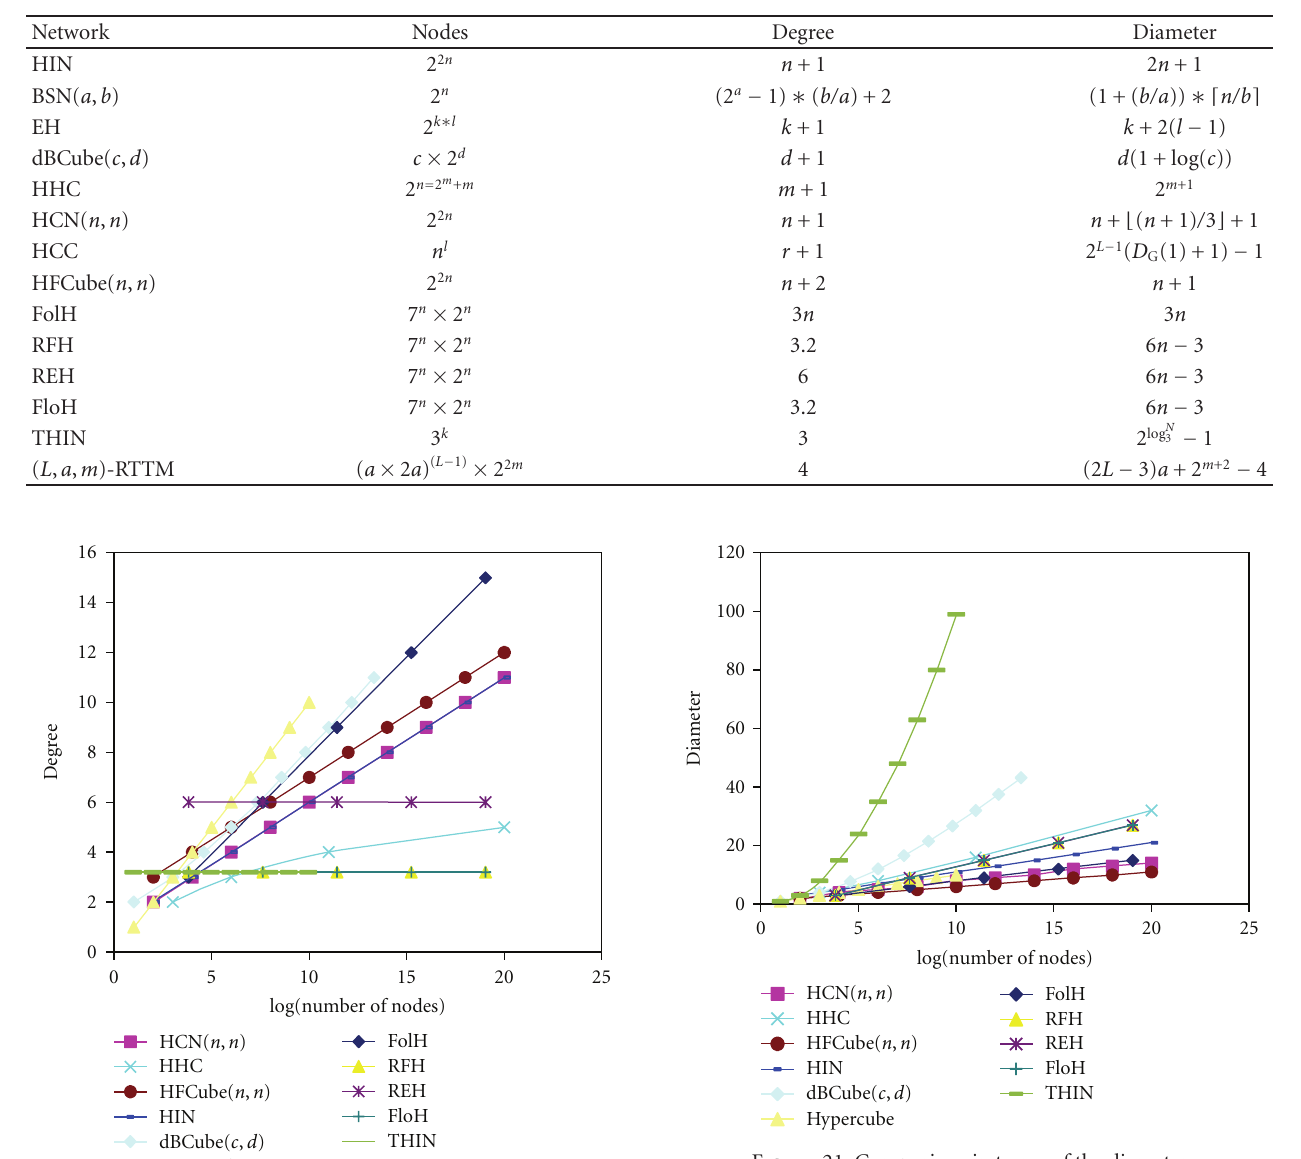
Table 1: Topological properties of HINs.